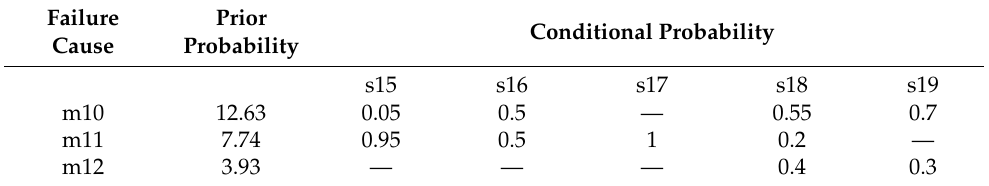
Table 3. The prior probability and conditional probability in the simple fault case.